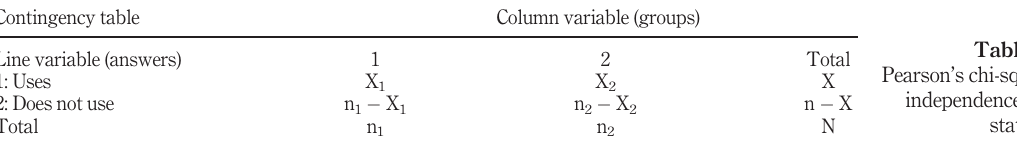
Table II. Pearson ’ s